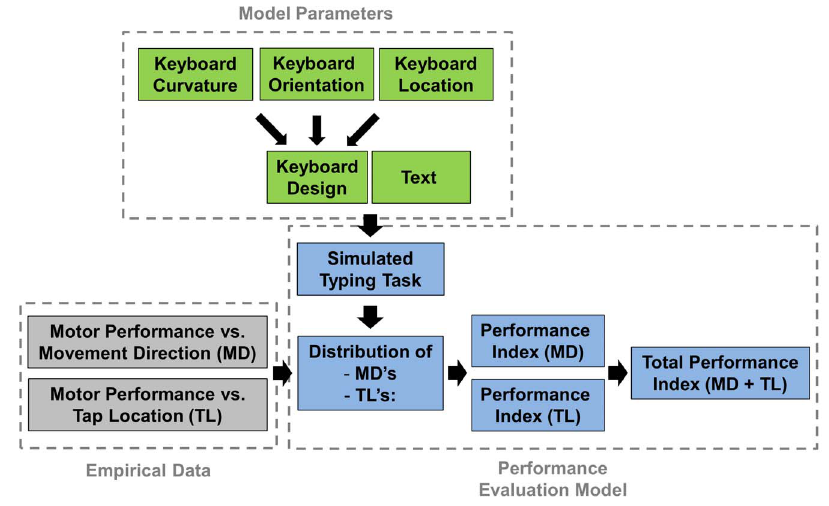
Figure 1. Flow chart describing the design evaluation tool.